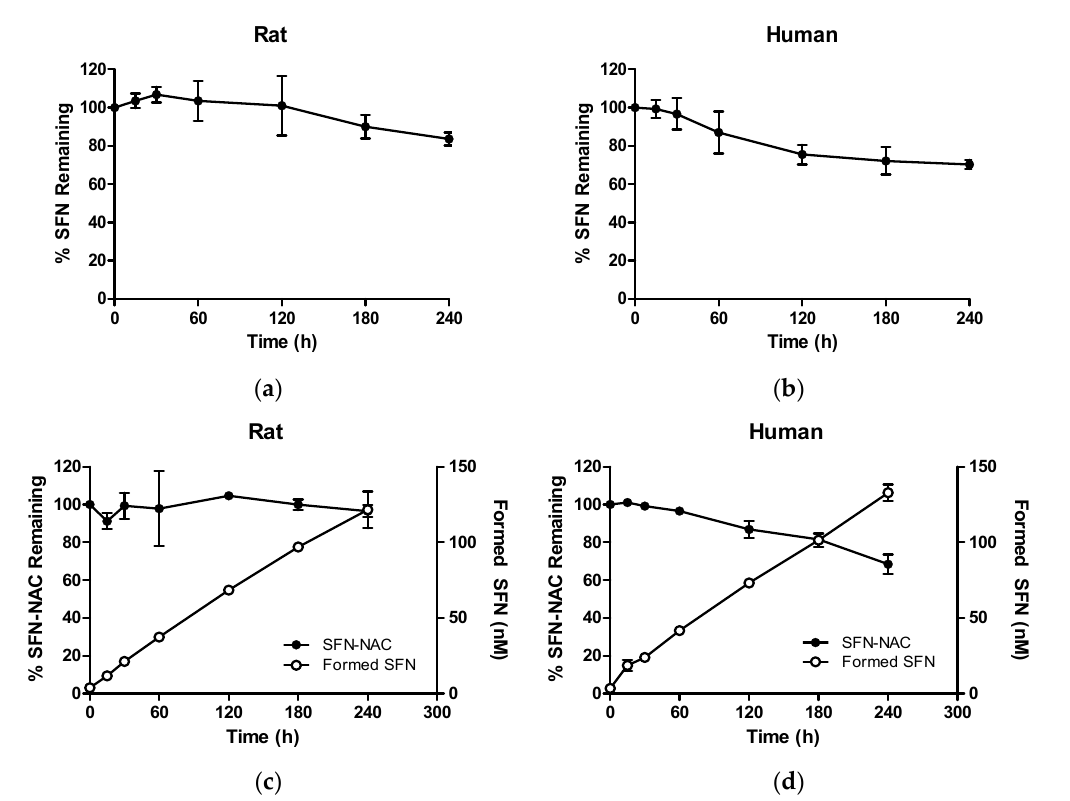
Figure 6. Percentages of SFN and SFN-NAC remaining as a function of time after incubation in liver microsomes: ( a ) SFN in rat liver microsomes; ( b ) SFN-NAC in rat liver microsomes; ( c ) SFN in human liver microsomes; ( d ) SFN-NAC in human liver microsomes. Data values are expressed as the mean ± standard deviation ( n = 3 at each point). SFN, sulforaphane; SFN-NAC, sulforaphane N -acetylcysteine.